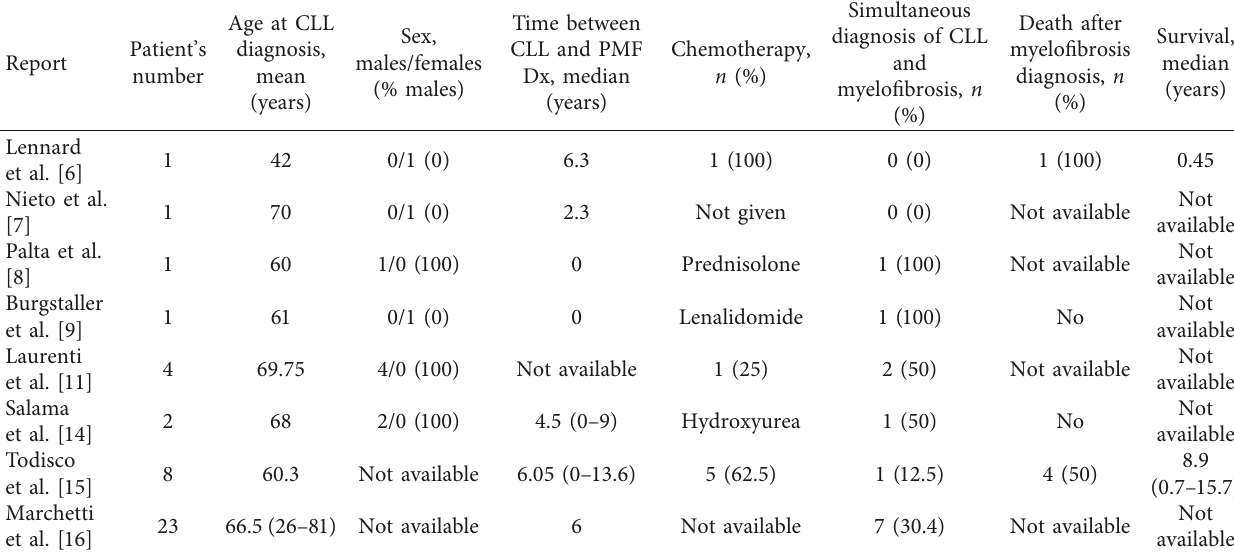
Table 1: Clinical characteristics of reported patients with CLL and PMF.